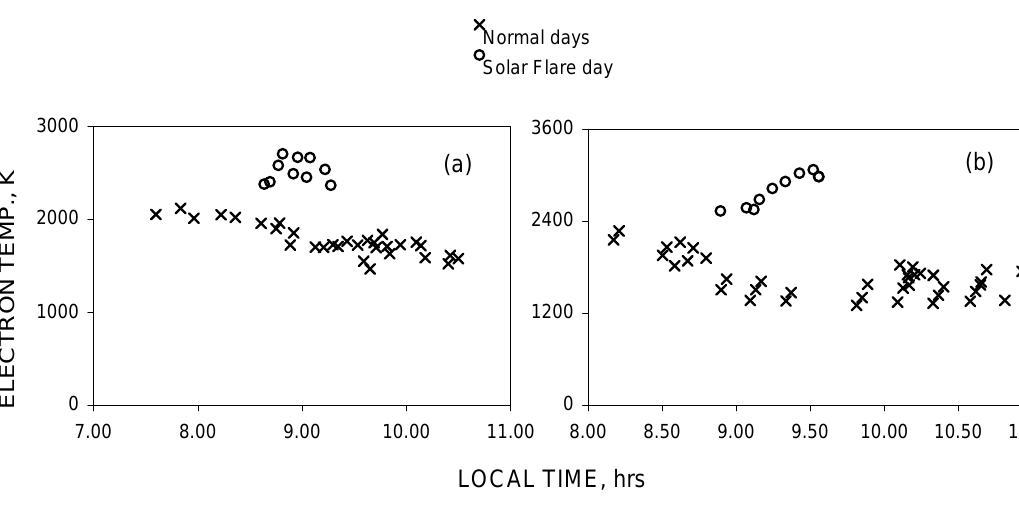
Fig. 5. Variation of electron temperature recorded by the SROSS-C2 satellite during solar flares and normal days at